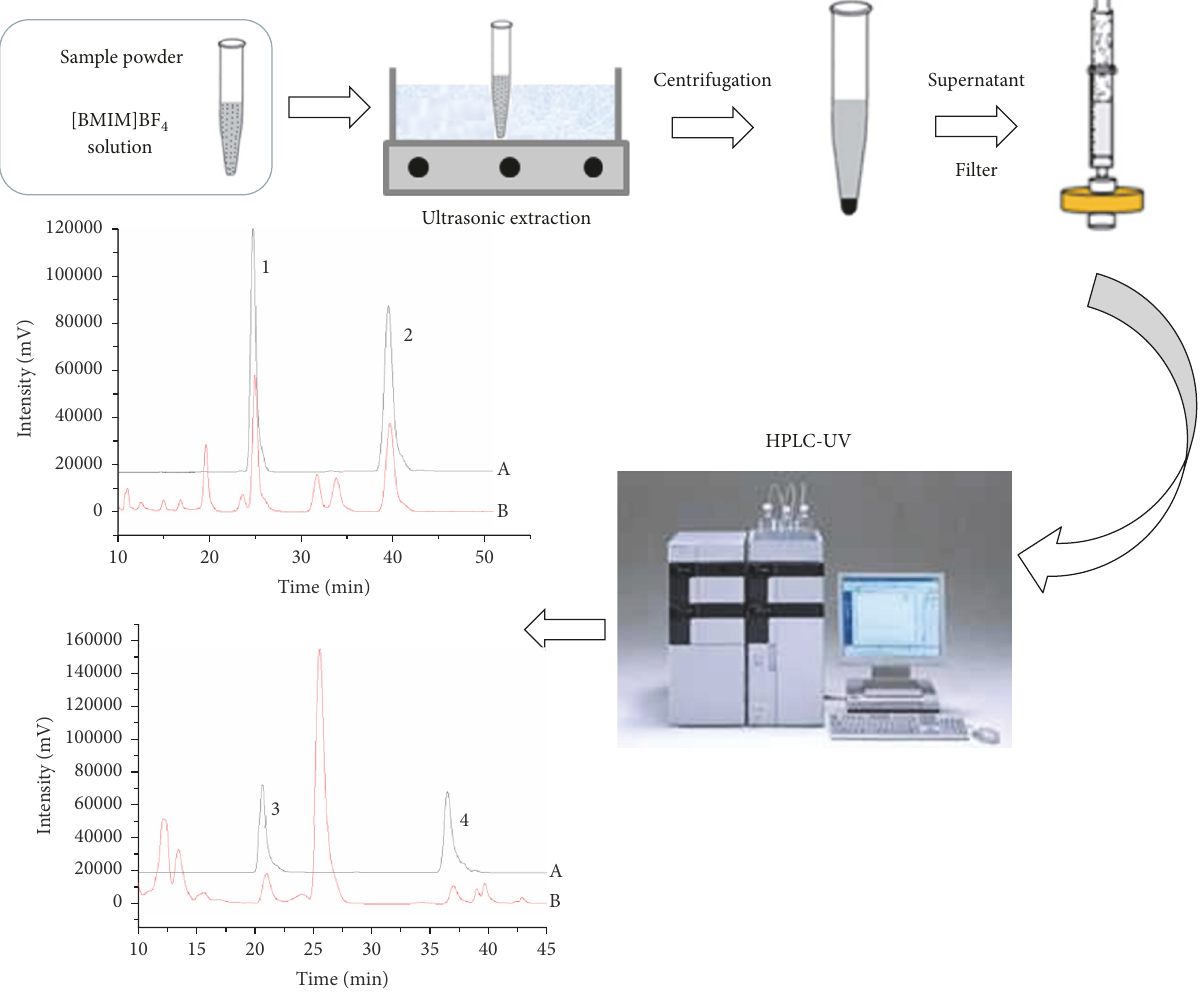
Figure 2: Schematic plot of the experimental